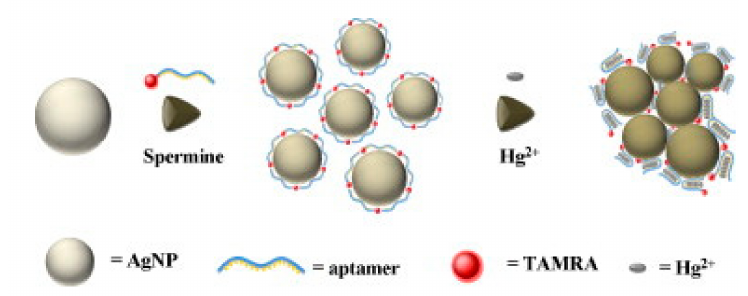
Figure 5. The formation of thymine (T)-Hg 2+ -T caused the aggregation of AgNPs [65].